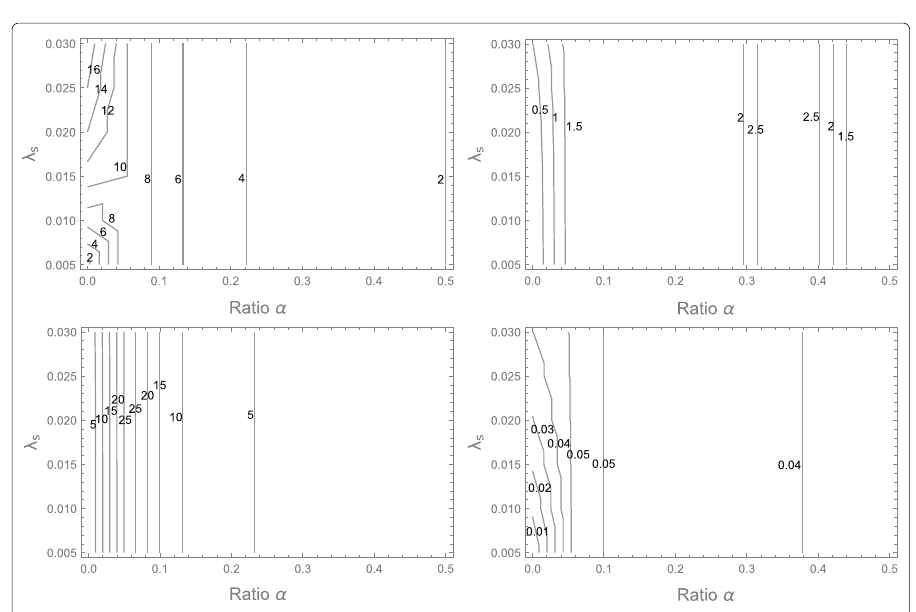
Fig. 7 Upper left: contour lines of W at λ n = 0.002 and β n = 0. Large-scale cascades emerge at α < 0.01. Upper right: contour lines of W at λ n = 0.001 and β n = 0. Large-scale cascades do not appear. Lower left: contour lines of W at λ n = 0.001 and β n = 0.7. Large-scale cascades emerge at α W ∈ ( 0.05,0.07 ) . They require somewhat weak social reinforcement. Lower right: contour lines of Q / T at λ n = 0.002 and β n = 0. Q / T is small if λ s and α are both small. For all figures, β r = 0.5 and N i = 10